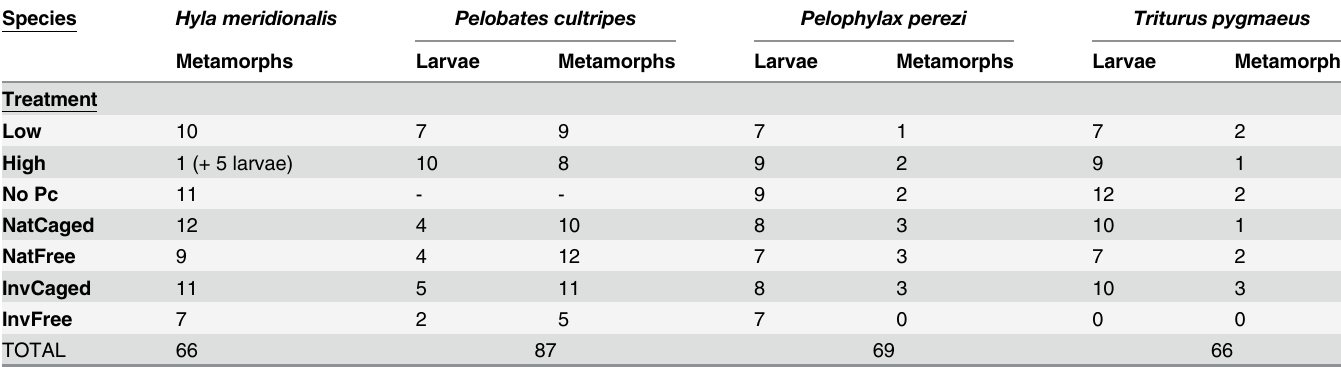
Table 2. Number of individuals (metamorphs and larvae) used for isotopic analyses in each species and